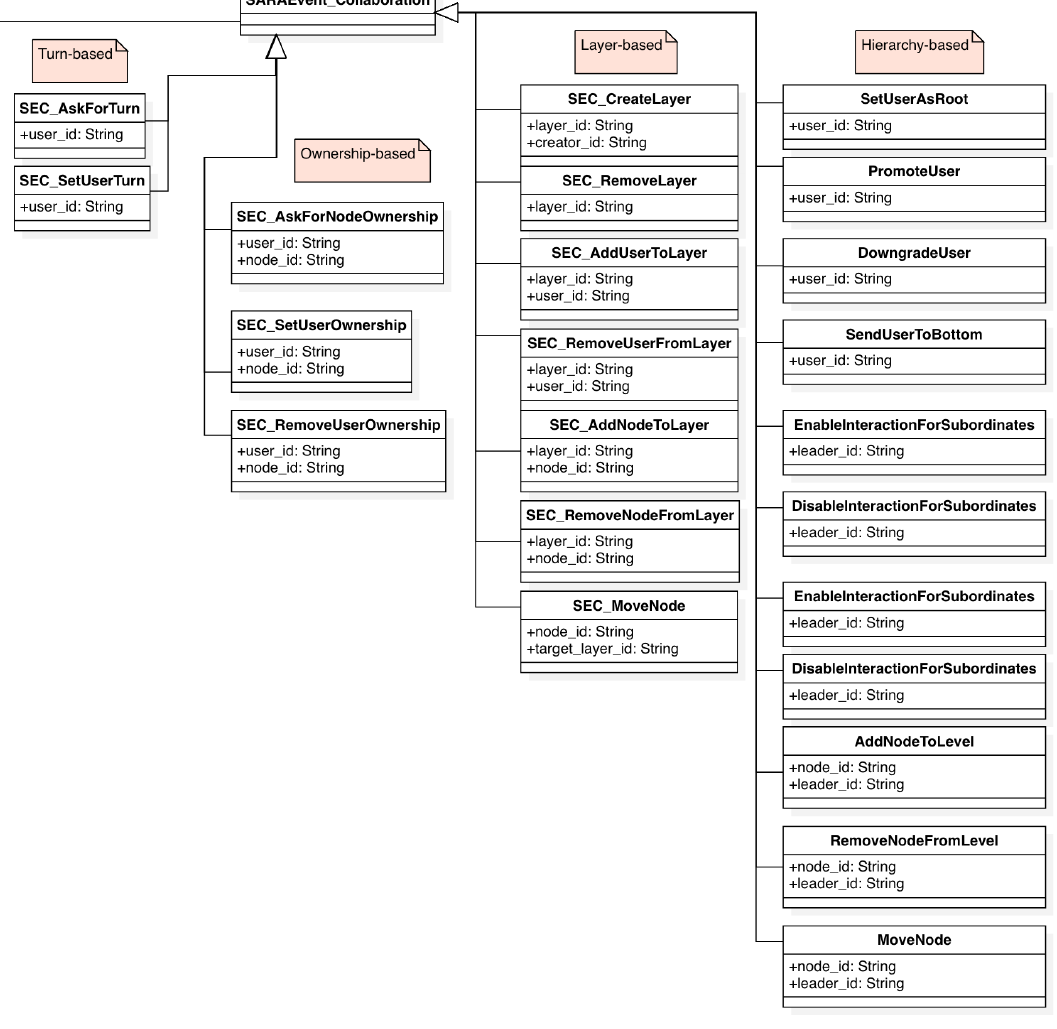
Figure 11. Data model of the Events required for each Collaboration